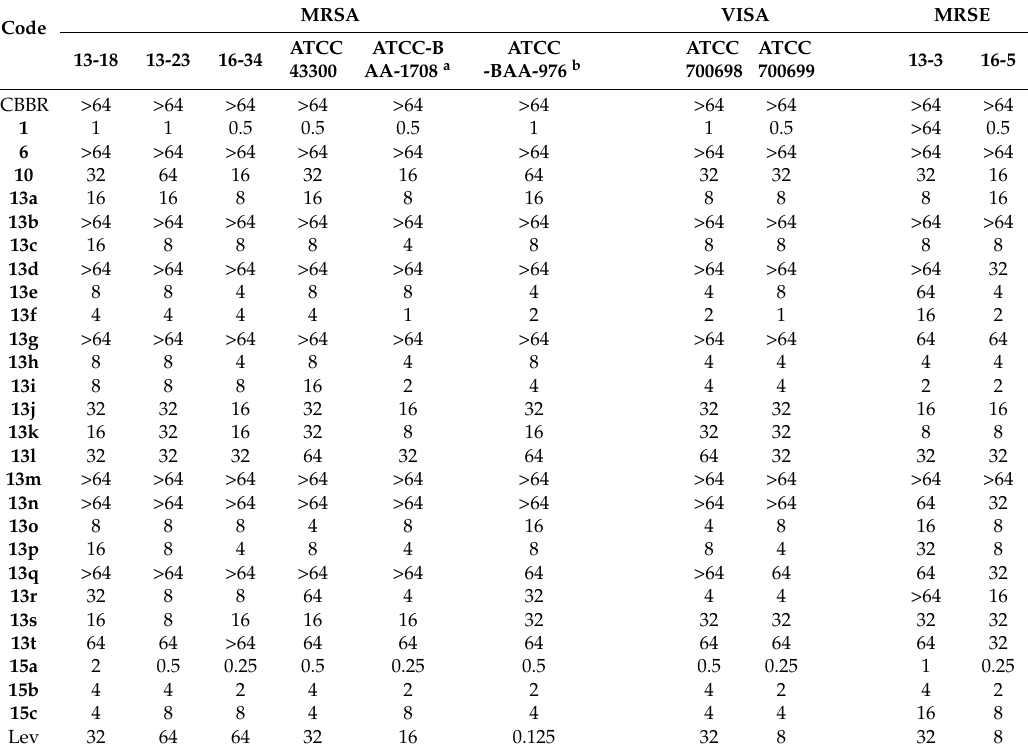
Table 2. Antibacterial activities of the target compounds against drug-resistant Gram-positive strains (MIC ( µ